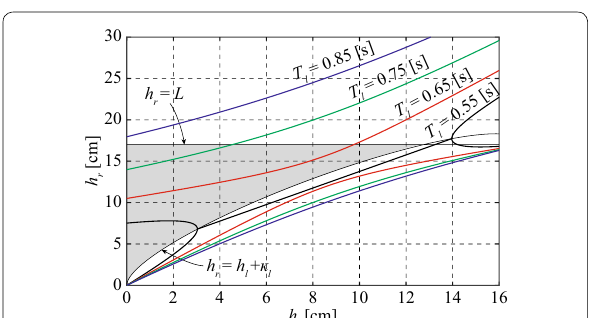
Fig. 6 Contour map of T l against h l and h r